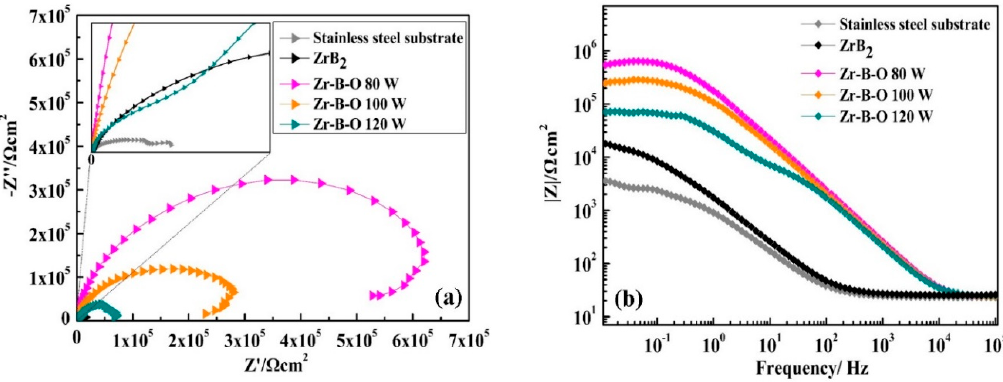
Figure 10. Electrochemical impedance spectroscopy (EIS) plots of the stainless-steel substrate, ZrB 2 monolayer and Zr-B-O nanocomposite films. ( a ) Nyquist plot. ( b ) Bode plot.